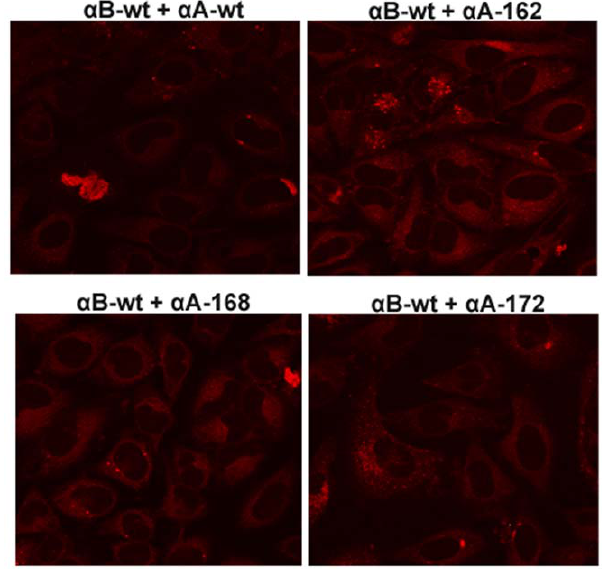
Figure 11. Aggresomes were not detected in CFP a B-wt co- expressing cells. There were no aggresome foci in a Bwt co-expressed cells with wild-type and the truncated constructs. The images are representative of four such images obtained in three independent experiments.